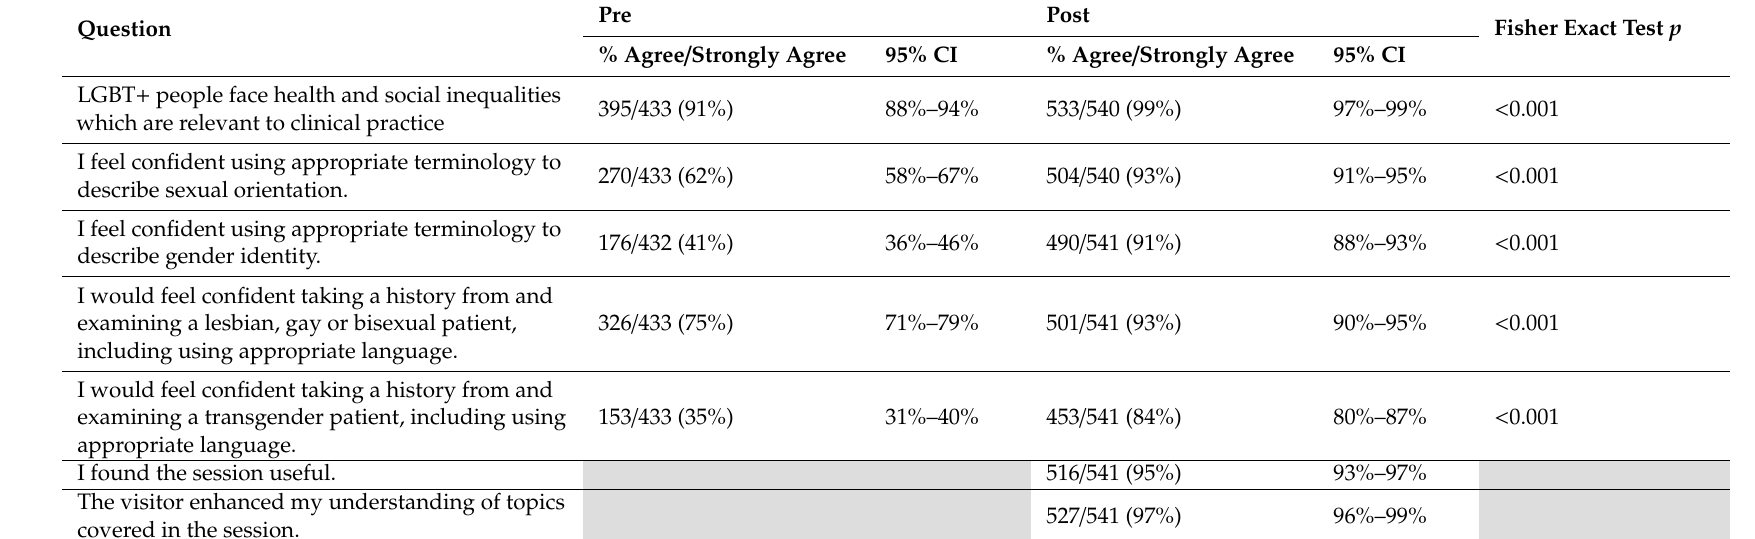
Table 1. Pre and post-session questionnaire results (2016–2019 data